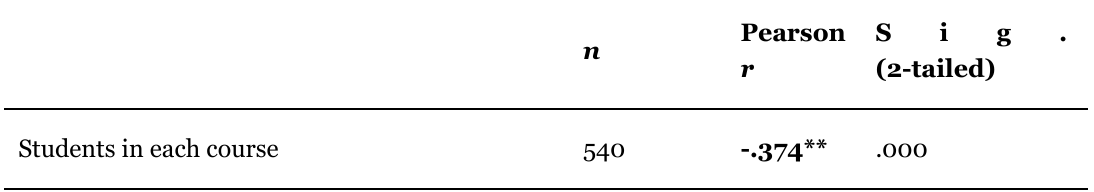
Students in each course 540 -.374** .000